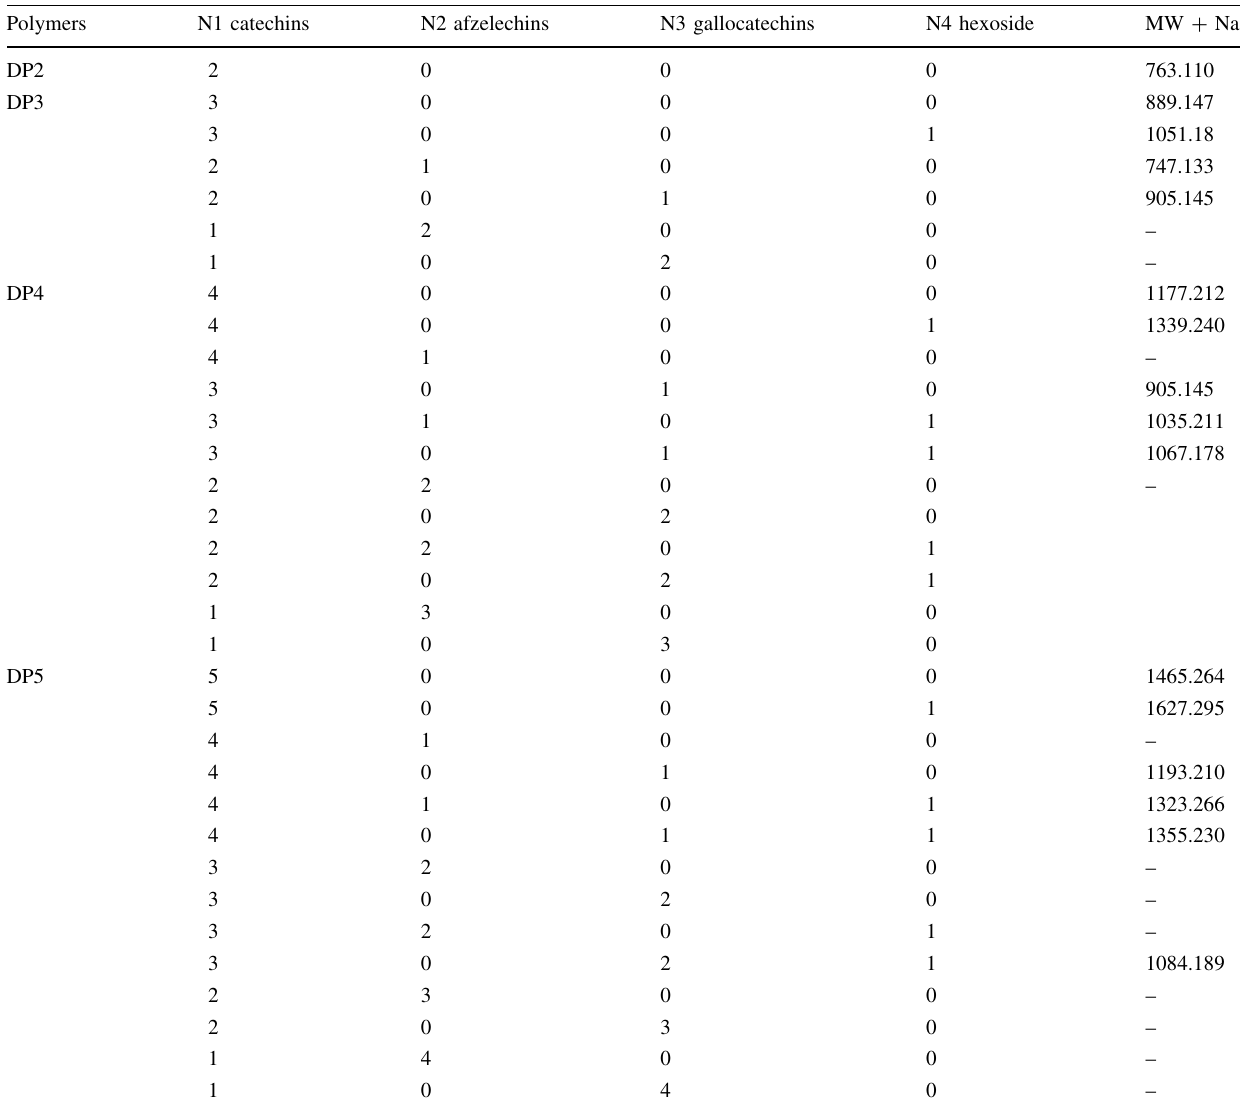
Table 2 Summary of peaks with the highest intensities in MALDI-TOF MS of the condensed tannins from AERM